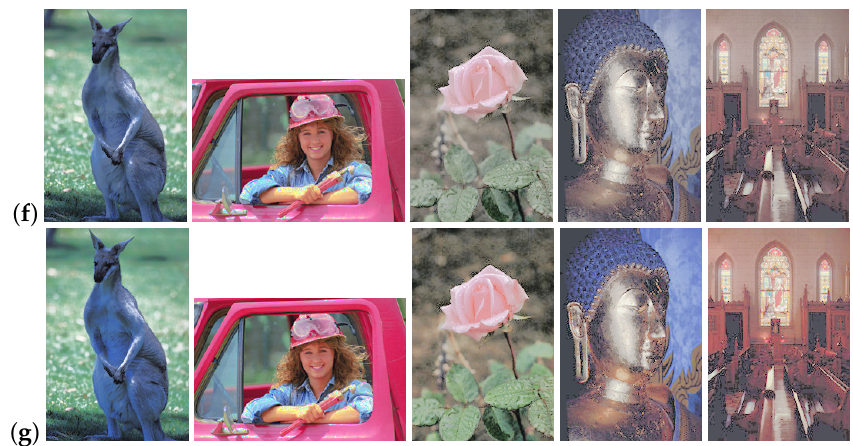
Figure 18. Assembled result: ( a ) original images, ( b ) Naik and Murthy’s method + HE, ( c ) Yang and Lee’s method + HE, ( d ) proposed method + HE, ( e ) Naik and Murthy’s method + HS, ( f ) Yang and Lee’s method + HS, ( g ) proposed method +